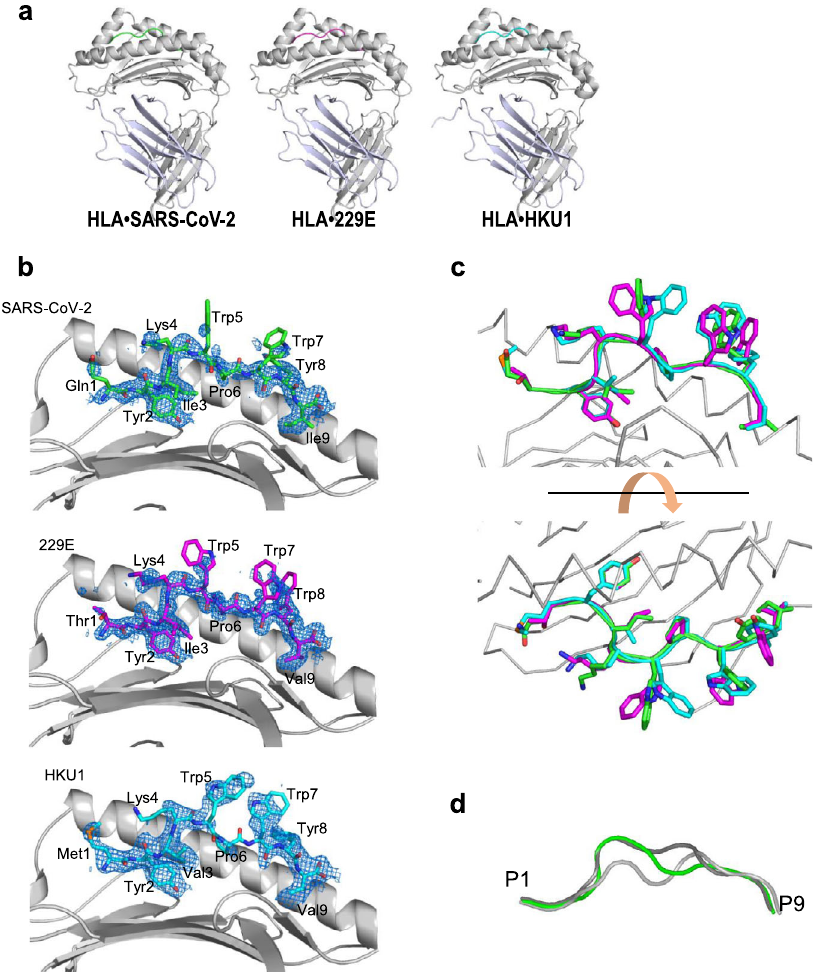
Fig. 8 Structure of the peptide-binding site. a Crystal structures of three HLA-A*24:02 (cid:129) peptide complexes. HLA-A24 structures are drawn as ribbon models in gray/light purple, and peptide structures are colored in green (CoV2), magenta (229E), and cyan (HKU1). b Electron densities of the peptides. The electron density for each peptide is contoured at 1.0 σ in the 2Fo-Fc omit map. Peptide structures are shown in green (CoV2, upper panel), magenta (229E, middle panel), and cyan (HKU1, bottom panel). c Superimposition of the three peptide structures. Peptide structures are depicted by the same colors as in ( b ). d Superposition of the 9-mer peptide structures in the HLA-A*24:02 (cid:129) peptide complexes. Peptides are shown in green (CoV2, this study), light gray (PDB code: 2BCK), and dark gray (PDB code: peptide 10 μ g/mL) and analyzed for cytokine production via intracellular cyto- kine staining. We used a graded dose of the peptide, ranging from 0.1 μ g/mL to 10 μ g/mL, to assess TCR avidity for each stimulating peptide. TCR avidity was assessed by %IFN- γ in CD8 + T cells. Furthermore, EC 50 was estimated by cal- culating the peptide concentration required to reach one-half maximum %IFN- γ reached in our assay. Single-cell TCR sequencing and construction of retroviral TCR vector . Single- cell TCR sequencing was performed as below. All primers used are listed in Sup- plementary Table 5. CoV-2 pep#3-speci fi c CD8 + T cell lines were restimulated with anti-human CD107a-BV421 in the presence or absence of 10 µM CoV-2 pep#3 for 6 h and then stained with anti-human CD8-PE and Aqua. The peptide- speci fi c CD8 + CD107a + cells were sorted as single cells into 5 μ L of RT-PCR mix in a 96-well plate, using FACS Aria III (BD Biosciences). The RT-PCR mix comprised 1µL of 5× Prime STAR GXL Buffer, 0.45µL RT-PCR primer mix, 0.4 µL of 2.5 mM dNTP, 0.05 µL of 40U/µL RNase Inhibitor, 200 U/µL PrimeScript II Reverse Transcriptase (Takara Bio Inc,), 0.05µL of 1.25 U/µL PrimeSTAR GXL DNA Polymerase (Takara Bio Inc.), and 2.95 µL nuclease-free water. The program used for the one-step RT-PCR was as follows: 45 °C for 40 min, 98 °C for 1min, and 35 cycles of 98°C for 10 s, 55 °C for 15 s, and 68 °C for 1min. The resultant PCR products were diluted 10-fold with nuclease-free water and used as templates for the 2nd-PCR. The 2nd PCR was performed using PrimeSTAR GXL with the pMXs-BamHI-InFusion primer and CA-rev2 primer for TCR α or CB-rev2 primer for TCR β in a 10 µL reaction volume. The program for the 2nd-PCR was as follows: 98°C for 1 min and 44 cycles of 98°C for 10 s, 55°C for 15 s, and 68°C for 1 min.